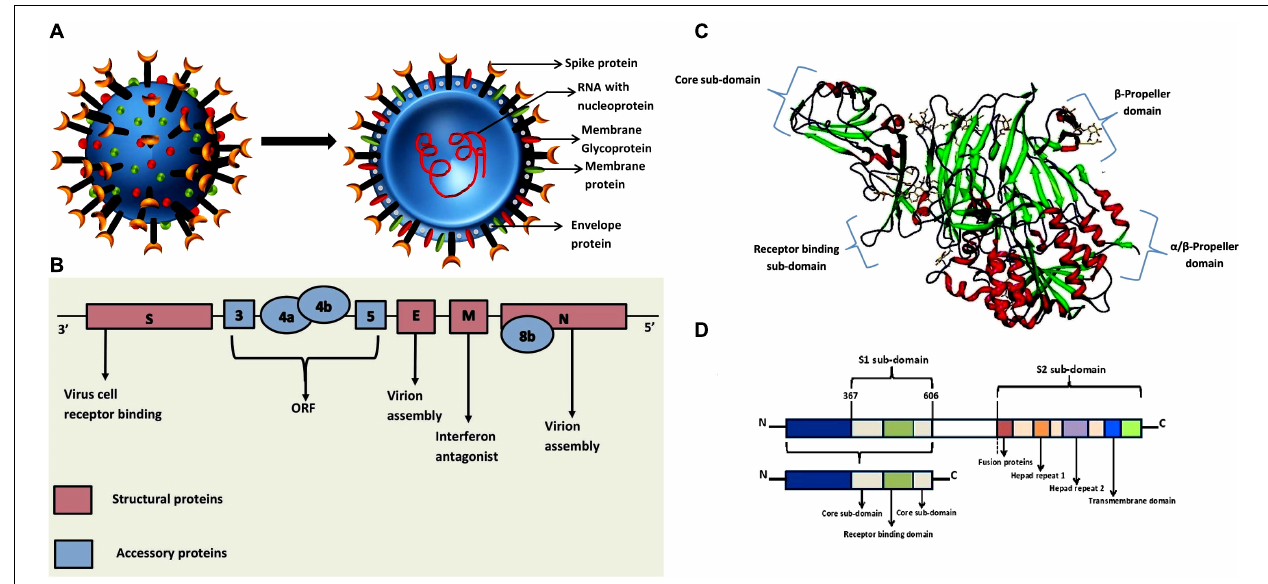
FIGURE 1 | (A) Graphical representation of the structure of the MERS-CoV. The schematic representation shows that the structure of Middle East Respiratory Syndrome Coronavirus, which contains the RNA enclosed in the nucleocapsid within the envelope that is embedded with spike proteins, glycoproteins and membrane proteins (van den Brand et al., 2015). (B) Genome organization of MERS CoV. The genomic organization of MERS-CoV displays the viral genes S, 3, 4a, 4b, 5, E, M, 8b, and N. The genome encodes for five unique accessory proteins such as 3, 4a, 4b, 5 and 8b and four major structural proteins which are illustrated in the genome scheme (Gao et al., 2016). (C) Experimental structure of MERS-CoV complexes with human DPP4 (PDB ID: 4L72). DPP4 is an extracellular RBD domain, which comprises of both N- and C-terminal. The N-terminal is the β -propeller domain and C-terminal is the α / β hydrolase domain (Wang et al., 2013). (D) Genome organization of receptor binding domain (RBD) that illustrates the S1 and S2 sub-domains (Zhang et al.,